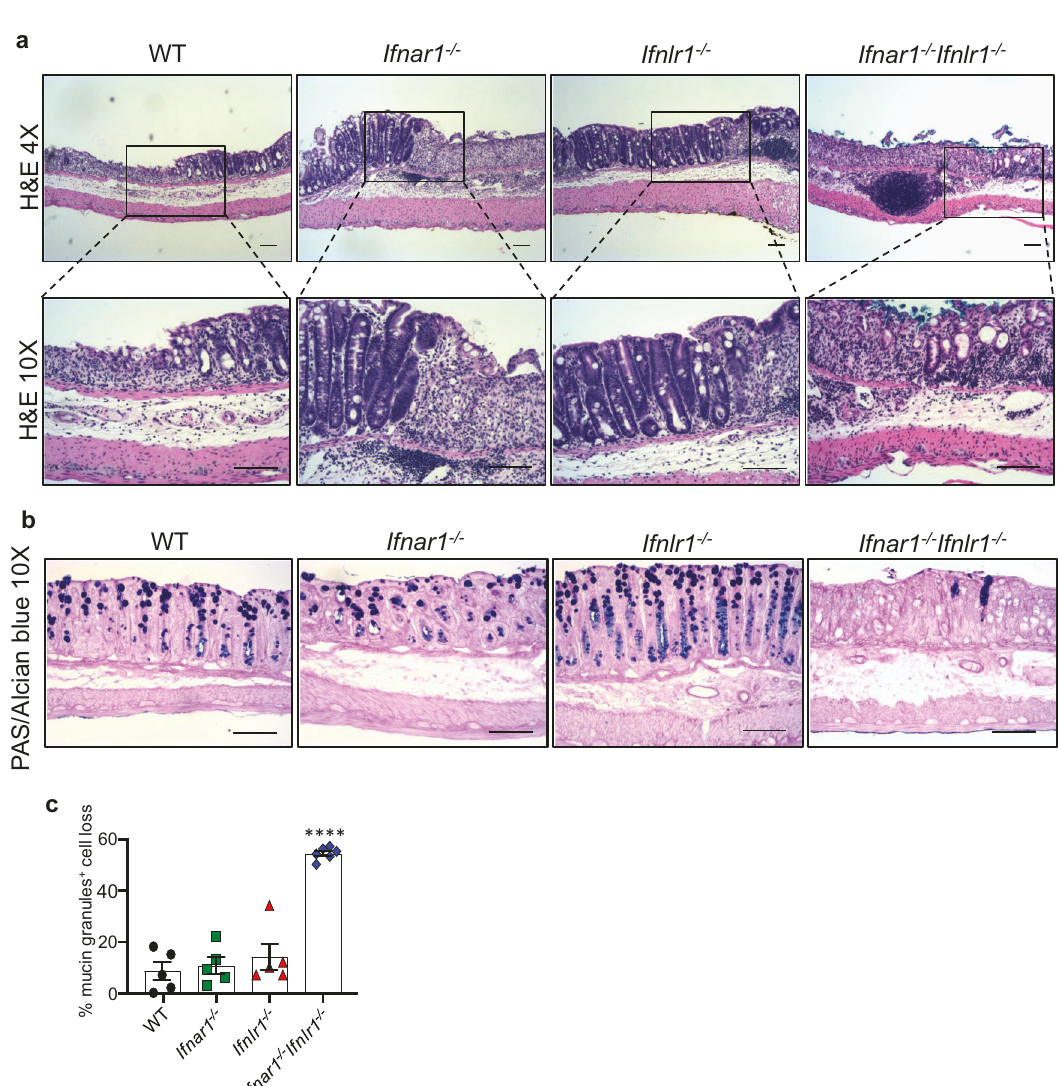
Fig. 2 Reduced number of goblet cells with mucin granules in the colon of Ifnar1 − / − Ifnlr1 − / − mice following DSS treatment. a – c 6 – 8-week-old WT, single or double IFNR-de fi cient mice were exposed to 1.5% DSS in drinking water for 7 days, followed by regular drinking water for recovery, and euthanized on day 11. Representative a H&E and b PAS/Alcian blue staining for mucin granules-containing goblet cells with c quantitated loss of goblet cells stained positive for mucin granules (WT, n = 5; Ifnar1 − / − , n = 5; Ifnlr1 − / − , n = 5; Ifnar1 − / − Ifnlr1 − / − , n = 6) are shown. Scale bars are 100 μ M. Data are representative of three independent experiments. Symbols represent values of individual mice ( c ). Quantitative data were analyzed using one-way ANOVA followed by Bonferroni ’ s multiple comparisons test and represent mean values with SEM. **** P ≤ 0.0001 and is for the indicated animal group compared with control group of WT